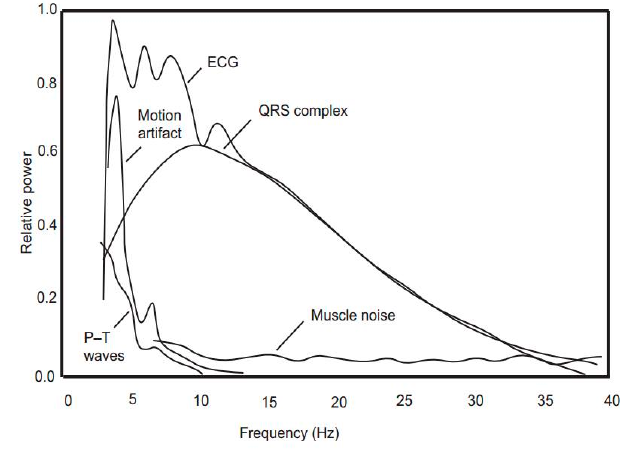
Figure 4. The sources of ECG noises.